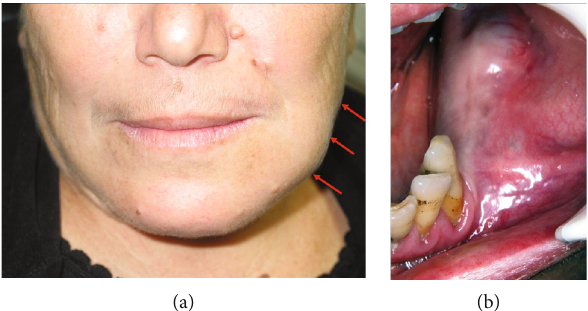
Figure 1: (a) Facial deformation in regard with the left mandible. (b) Tumefaction fi lling the buccal posterior area of the mandible.